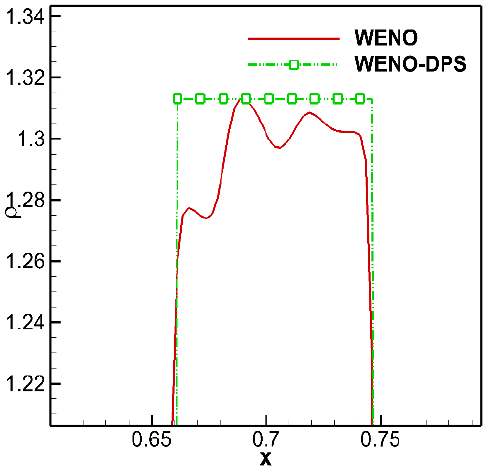
Figure 11. Density plot of Lax test case with